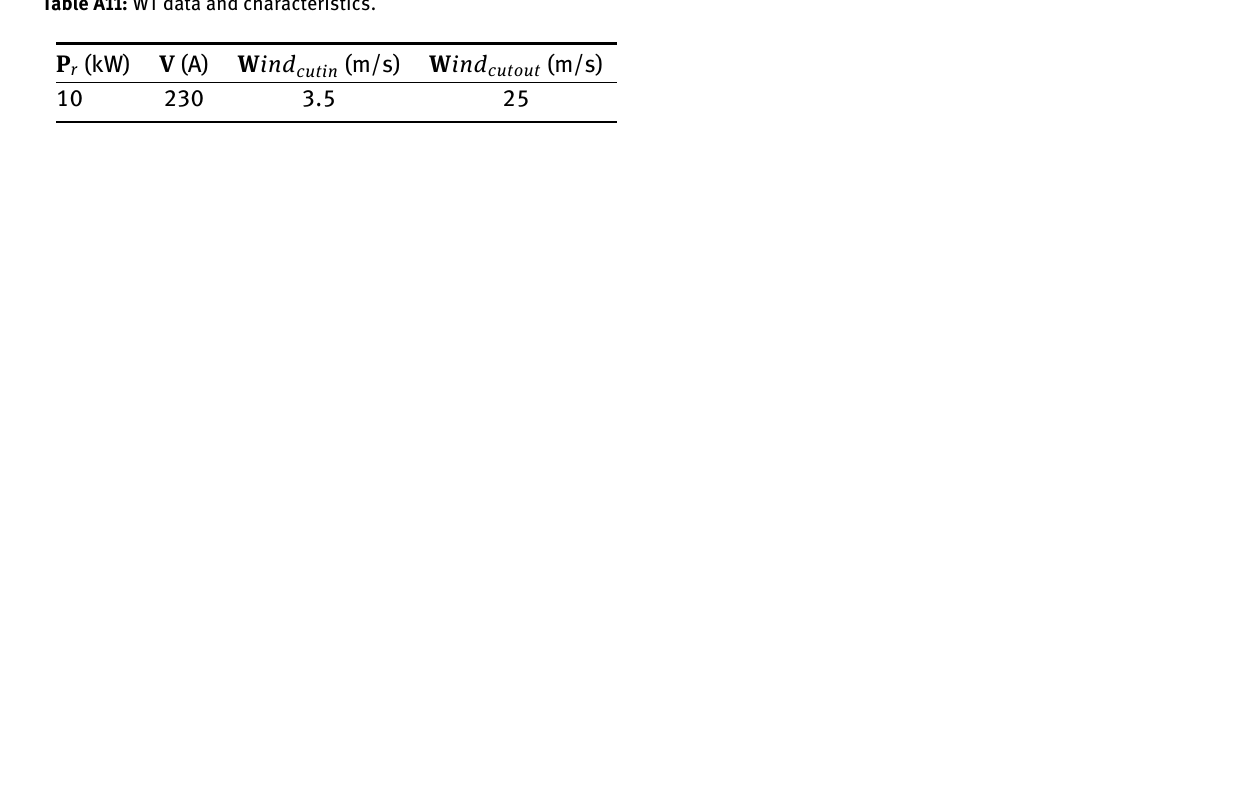
Table A11: WT data and characteristics.